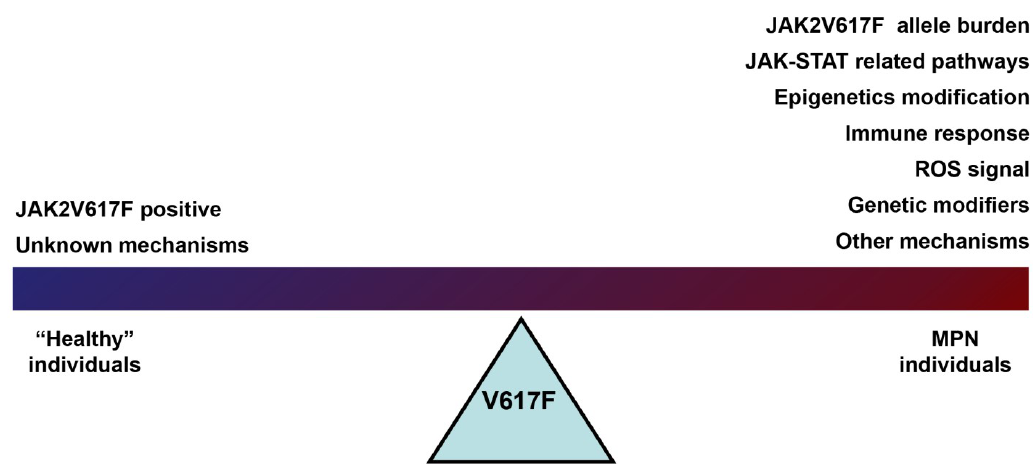
Figure 4. Model of JAK2V617F positive contributing to MPN phenotype. Table 1. JAK2V617F cooperate with different factors contribute to phenotype of MPN.